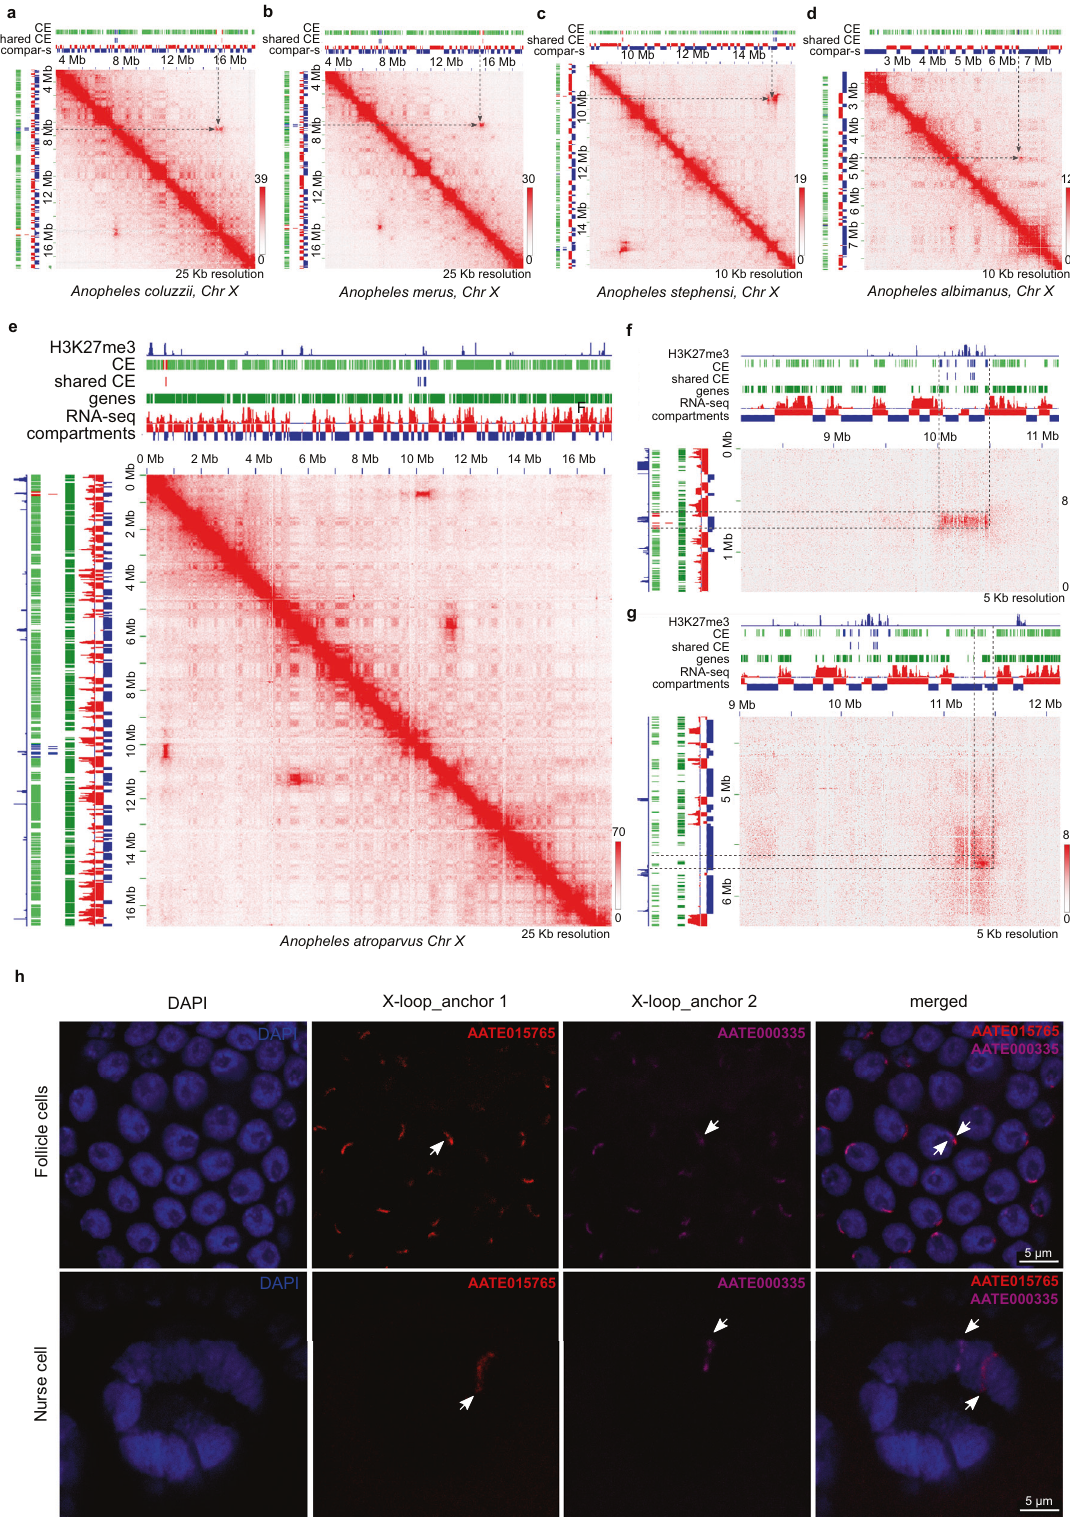
Fig. 7 Long-range interactions identi fi ed on Hi-C maps and loop validation by FISH. a – d X-loop in An. coluzzii ( a ), An. merus ( b ), An. stephensi ( c ), An. albimanus ( d ); e Region of An. atroparvus chromosome X Hi-C map, showing the X-loop and another giant loop identi fi ed on the X chromosome; f , g Zoomed-in regions of two loops identi fi ed on the X chromosome in An. atroparvus . Color bars near the heatmaps re fl ect the contact frequency. The red tracks are CEs within the fi rst anchor of the loop. The blue tracks are CEs within the second anchor of the loops. The green tracks are the other CEs. h Colocalization of X-loop (showed on g ) anchors identi fi ed by 3D FISH in follicle cells but not in nurse cells of An. atroparvus